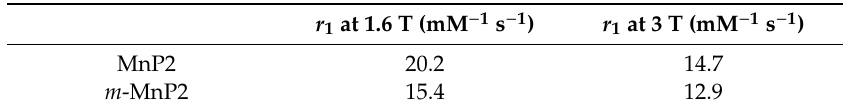
Table 1. r 1 of free MnP2 and m -MnP2 at clinical magnetic fields normalized per Mn, measured in